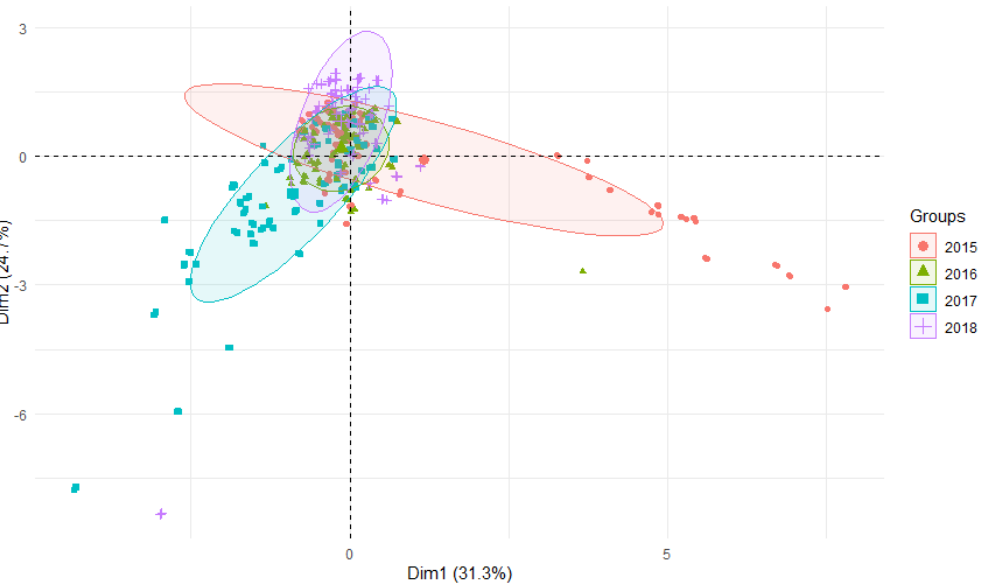
Figure 10. PCA plot 2D showing clustering of metals concentration in plants from rivers across 29 sites and 4 years (2015–2018) grouping factor—year.